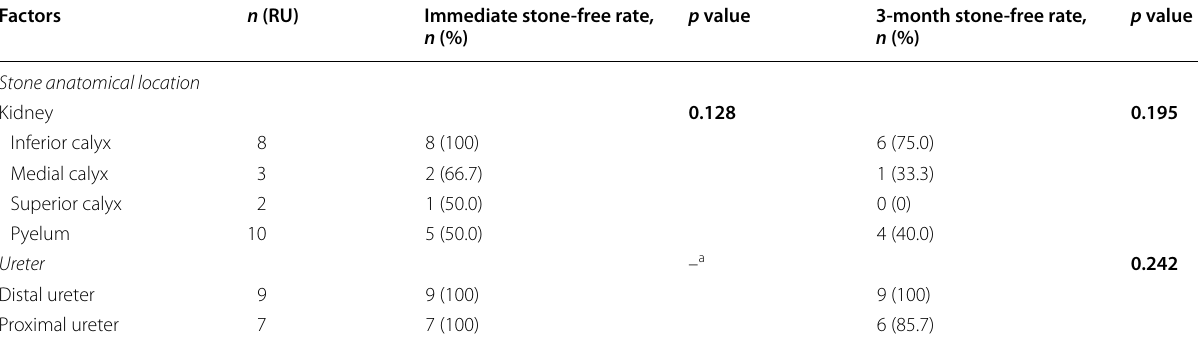
Table 4 Subgroup analysis of stone anatomical location and its association with immediate stone-free rate and 3-month stone-free